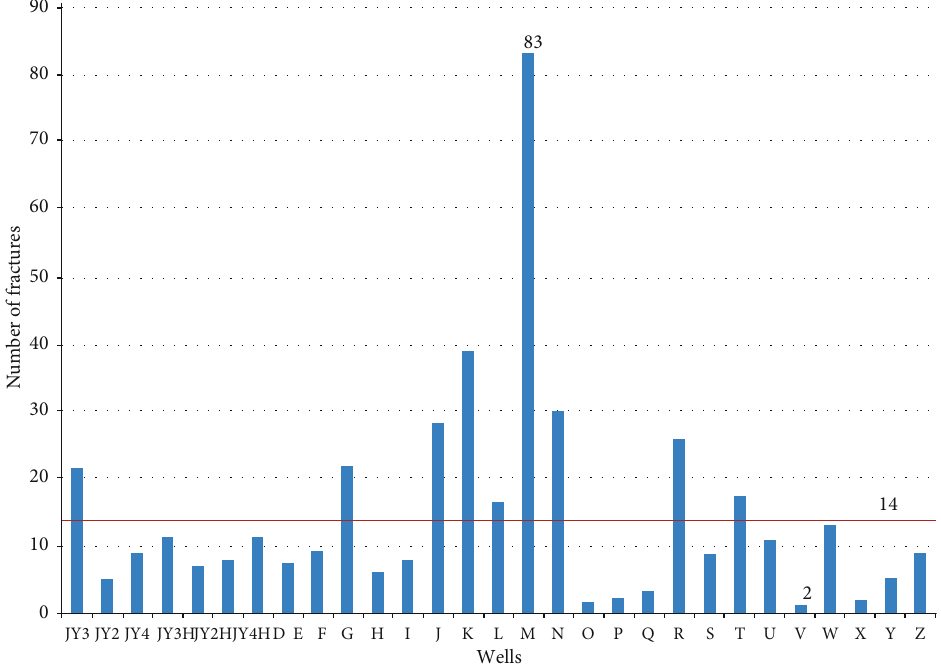
Figure 16: The fracture number statistics of the shale gas reservoir fracture model at the drilling location in the study